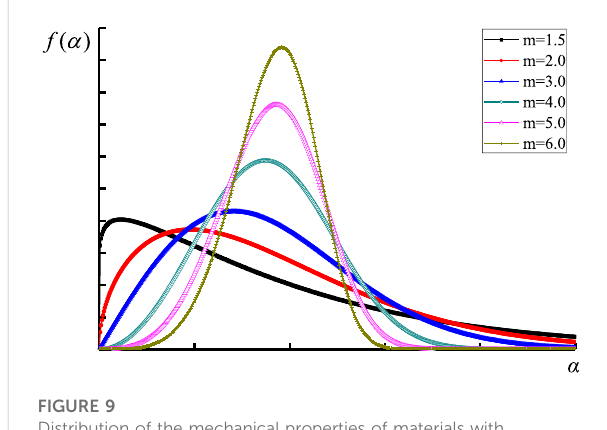
FIGURE 9 Distribution of the mechanical properties of materials with different homogeneity indexes m